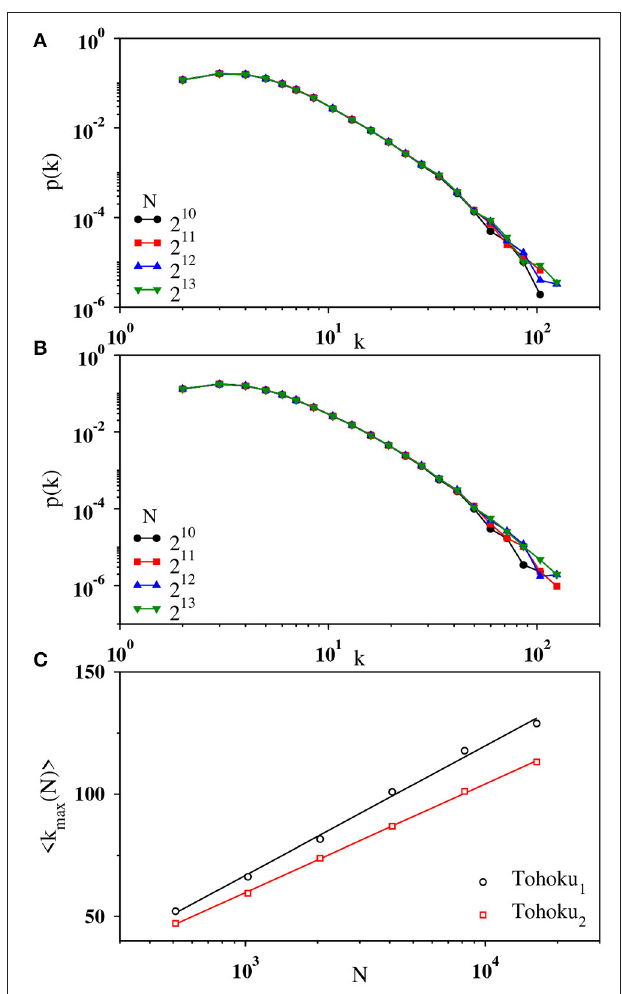
FIGURE 2 | Log-log plot of the binned data for degree distribution p ( k ) associated with the magnitude time series (A) Tohoku 1 and (B) Tohoku 2 for network sizes N 2 10 (black), 2 11 (red), 2 12 (blue), and 2 13 (green). (C) The = variation of the average maximum nodal degree scale for Tohoku 1 (black) and Tohoku 2 (red) using N line) of the data points by a straight line indicating the logarithmic growth of k max ( N ) h i